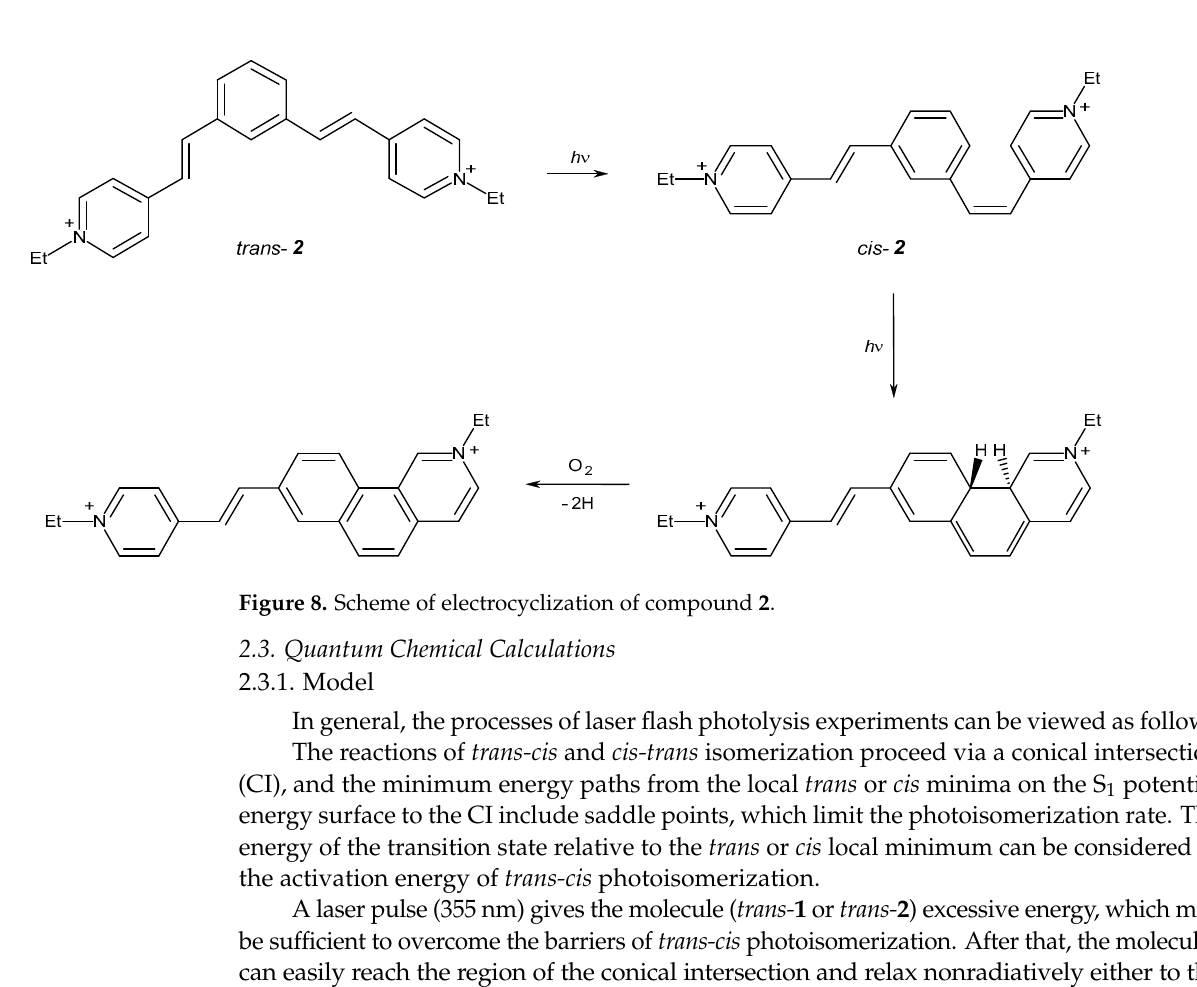
( b ) Figure 7. Absorption spectra of compounds 1 ( a ) and 2 ( b ) measured upon UV irradiation at vari- ous times as indicated in the insets. The concentration of compounds 1 and 2 was 5 × 10 –5 mol/L. Upon UV irradiation, an increase in optical density of the solution of compound 1 was observed, which corresponds to a photoinduced change in absorption measured upon laser excitation (Figure 4) and attributed to the formation of a long-lived cis isomer of 1 , which has an absorption spectrum similar to that of the trans isomer and a signifi- cant extinction coefficient. On the contrary, UV irradiation of compound 2 results in a decrease in absorption of the principal absorption band and an increase in absorption in the short-wavelength re- gion of the spectrum, which is consistent with the experimental data obtained upon laser excitation. It can be assumed that for compound 2 , photoelectrocyclization takes place to